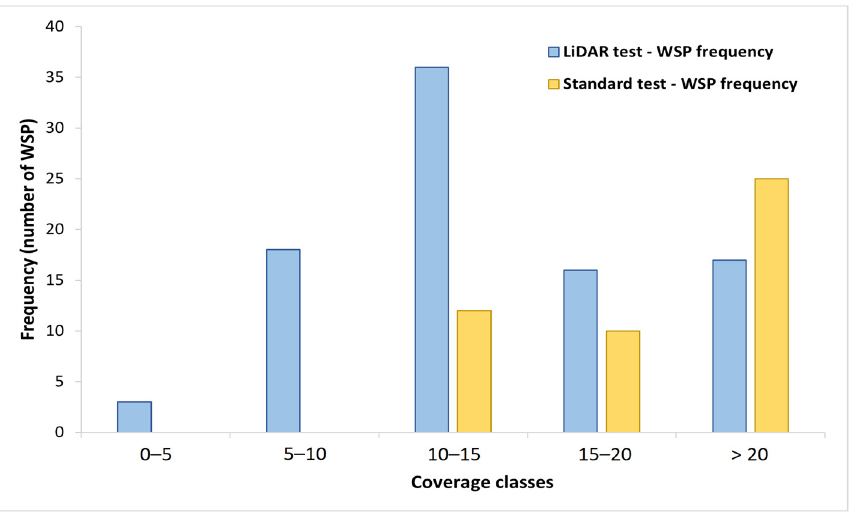
Figure 10. Frequency plot describing WSP frequency both in the LiDAR test (in blue) and standard test (in yellow) for different coverage classes (expressed as percentage range).